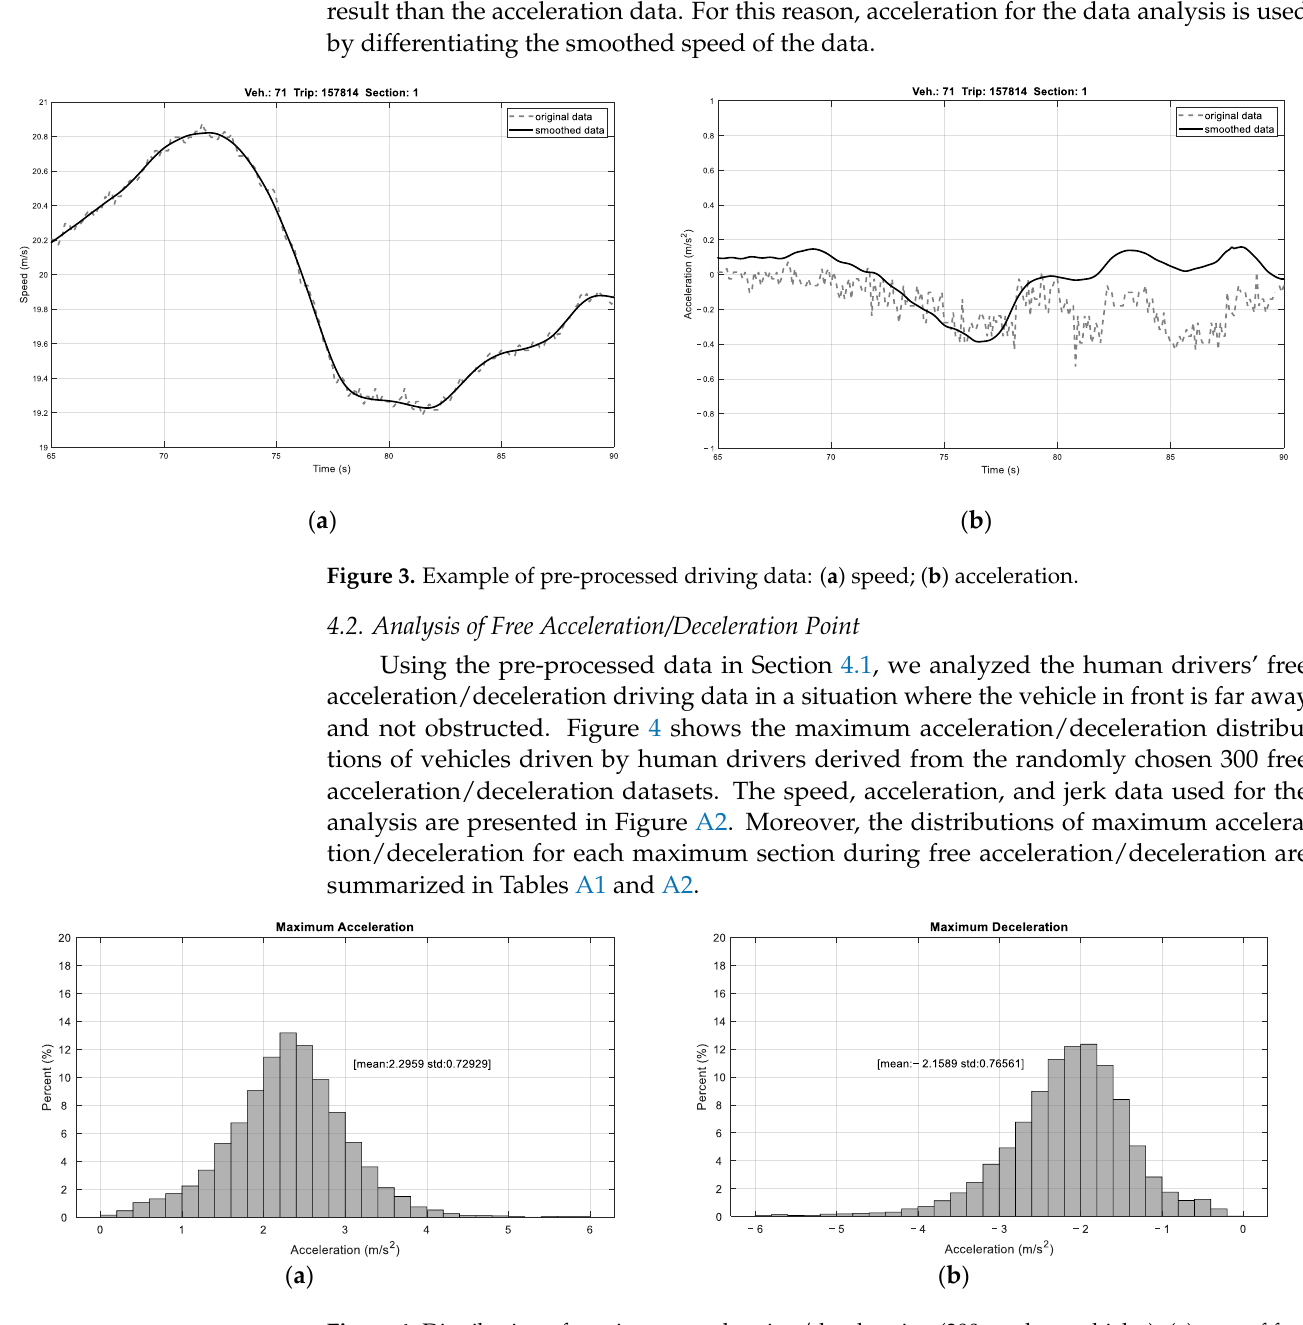
Figure 4. Distribution of maximum acceleration/deceleration (300 random vehicles): ( a ) case of free acceleration; ( b ) case of free deceleration.